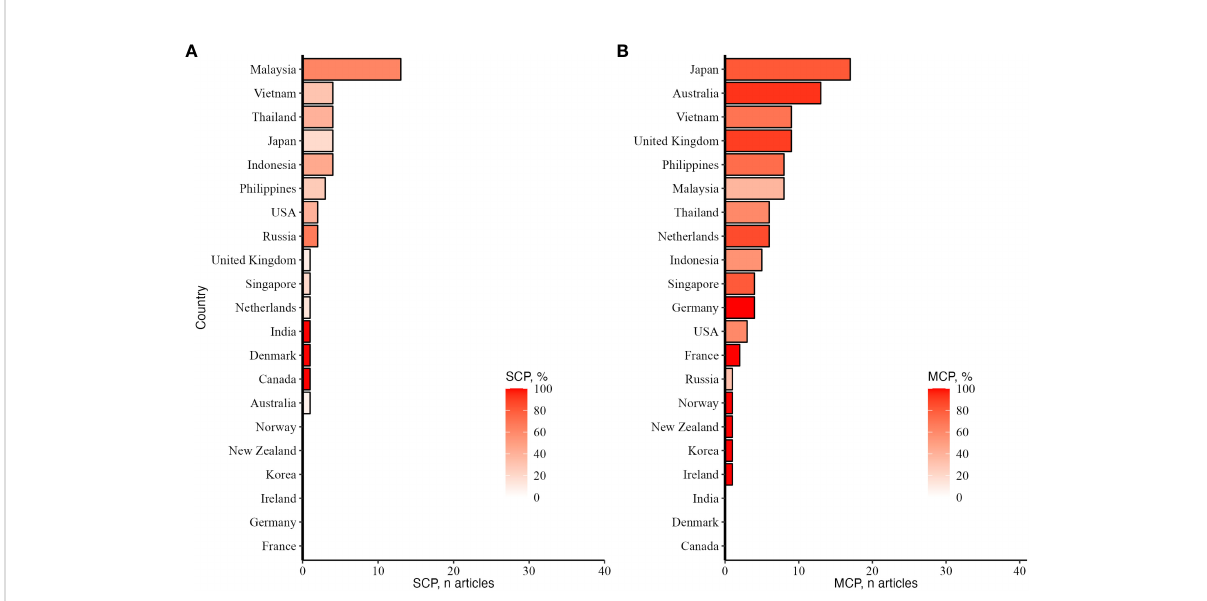
FIGURE 5 Top countries involved in mangrove restoration studies in SE Asia as (A) single-country publications (SCP) and (B) multiple-country publications